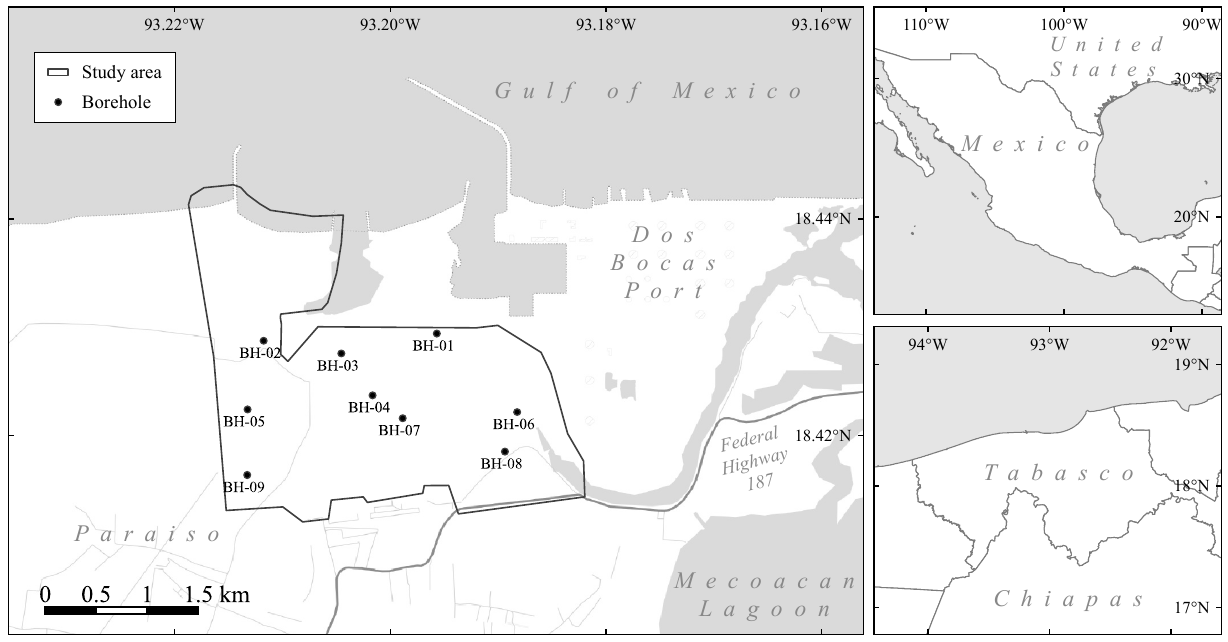
Figure 1. Study site and borehole locations.